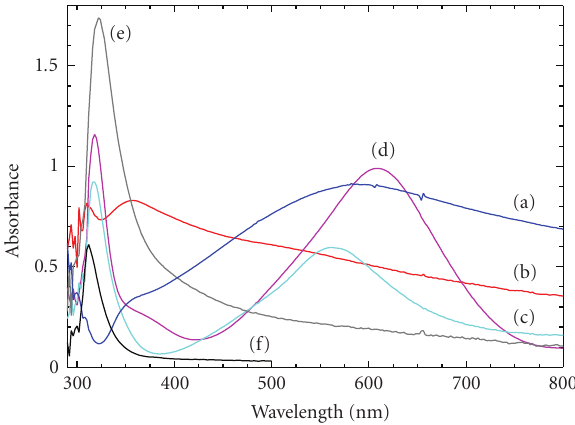
Figure 4: UV/Vis spectra of (a) thick layer of Ag (30 passes), (b) TiO 2 on Ag (30), (c) TiO 2 (TTIP) over Ag (4 passes), (d) Annealed TiO 2 (TTIP) over Ag (4 passes), (e) thin layer of Ag (2 passes) over TiO 2 , (f) commercial TiO 2 on